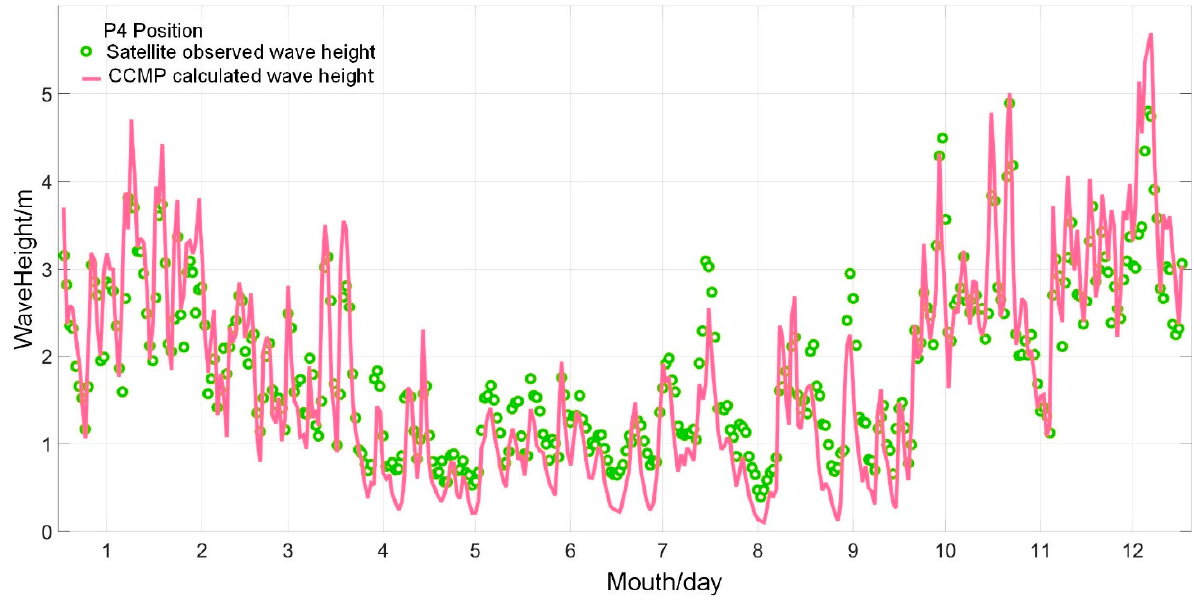
Figure 5. Observed and calculated wave height variation trend at the P4 position. The pink line represents the simulated wave height of the CCMP wind field, and the green dotted line represents the observed data of the altimeter.